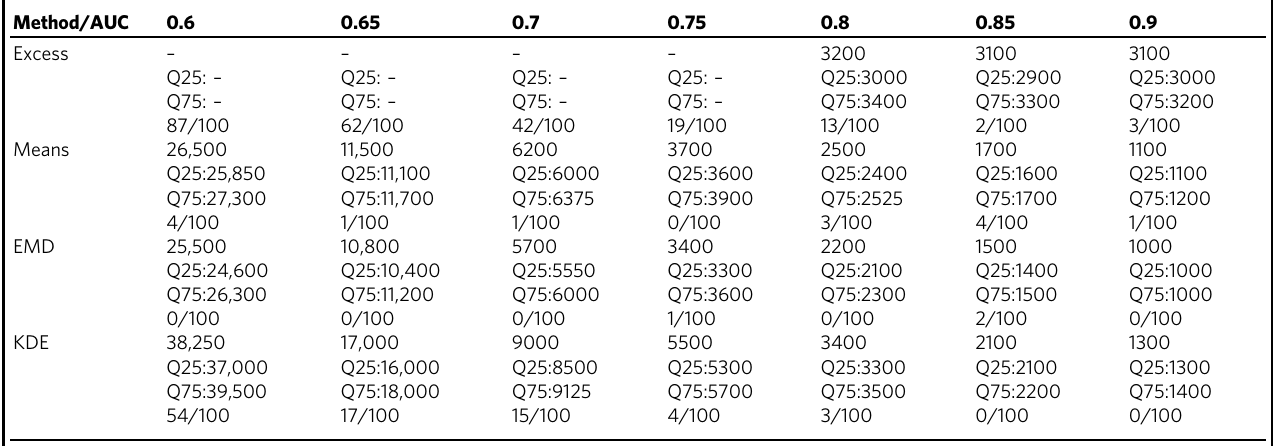
Table 1 The minimum mixture size required to give precision of ±0.05 around a prevalence of 0.1 with increasing AUC.